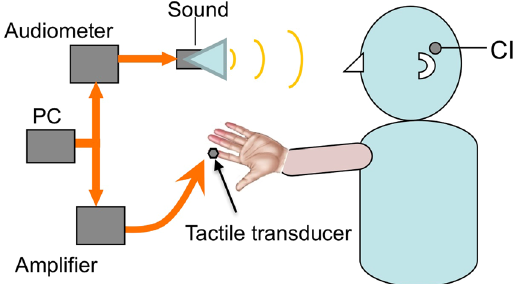
Figure 2. The ETS experimental setup. A personal computer (PC) controls both electric and tactile stimulation. Electric stimulation is delivered to a cochlear implant (CI) through an audiometer and speaker. Tactile stimulation is delivered to the index finger through an amplifier and a tactile